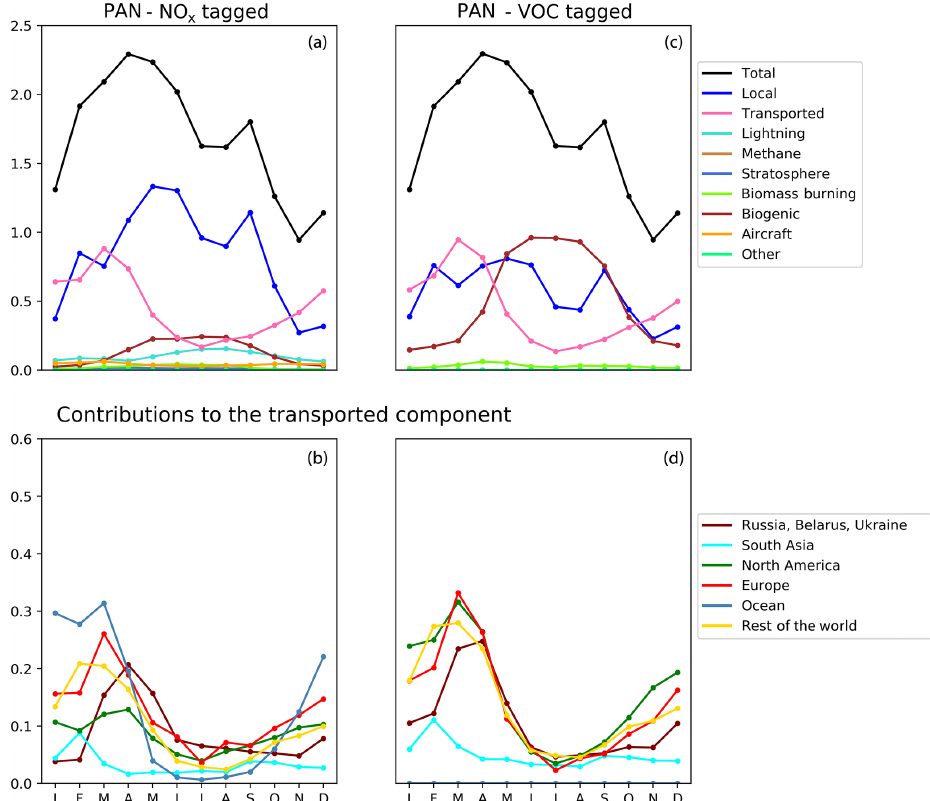
Figure 9. Seasonal cycle of column-integrated lower tropospheric PAN (10 − 15 molec.cm − 2 ) in the HTAP Tier 2 receptor region “North East China”. The lower troposphere is defined here as all model levels between 800 and 500hPa. NO x tagging is shown in panels (a) and (b) , and reactive carbon tagging is shown in panels (c) and (d) . Panels (a) and (c) show total monthly mean PAN (black line) as well as the local anthropogenic component, the long-range transported anthropogenic component, and the natural components. Panels (b) and (d) show the individual Tier 1 source regions responsible for the long-range transported component of